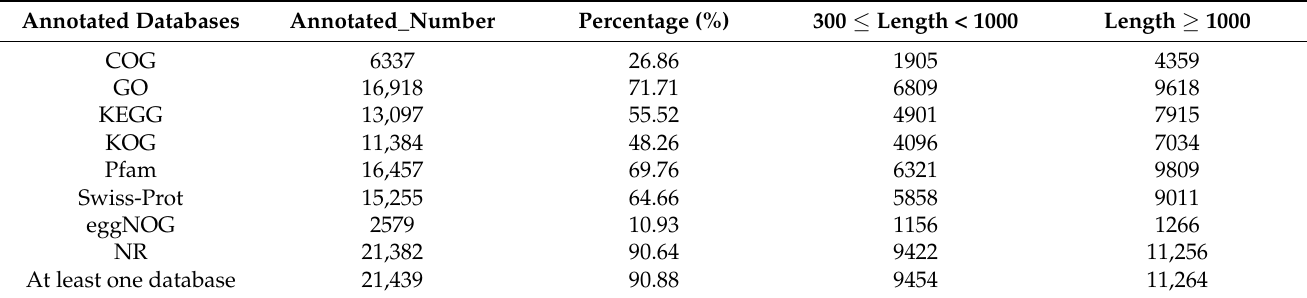
Table 2. Gene functional annotation